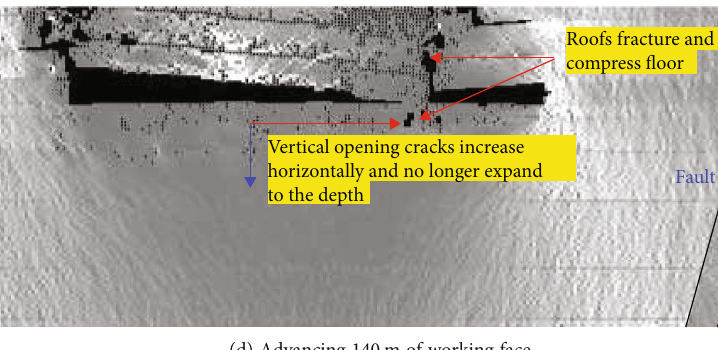
Figure 9: Mining crack evolution process (75 ° , project